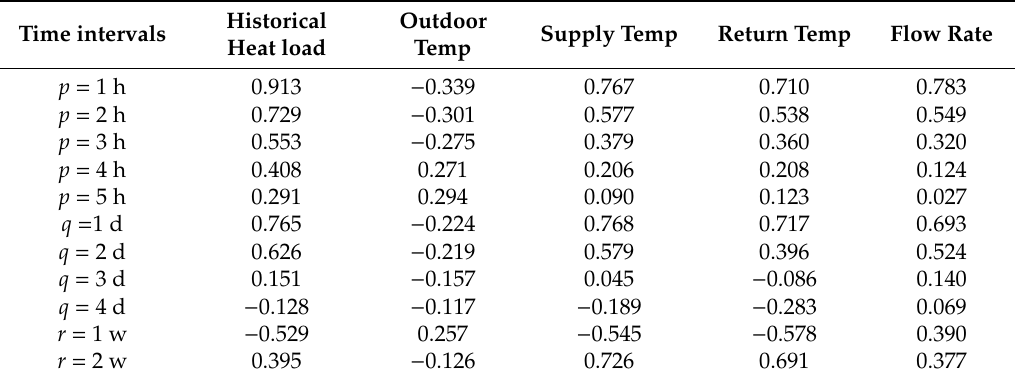
Table 2. The correlation value of heat load versus other